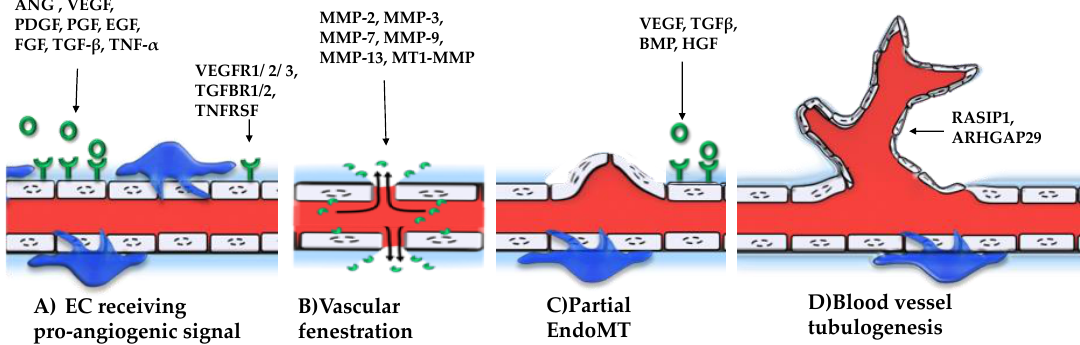
Figure 1. The angiogenic process has four main steps. ( A ) The endothelial cells (EC) found at the outer surface of a blood vessel, receive pro-angiogenic signals from the following factors: Angiogenin (ANG), Vascular Endothelial Growth Factor (VEGF), Platelet Derived Growth Factor (PDGF), Placental Growth Factor (PGF), Epidermal Growth Factor (EGF), Growth Factor Form Fibroblast (FGF), Transforming Growth Factor Beta 1 (TGF B), and Tumor Necrosis Factor Alpha (TNF- α ). The angiogenic growth factors have several corresponding receptors on the surface of EC, for instance VEGFR1/2/3, TGFBR1/2, TNFRSF. After signal transduction in the EC, these cells start to produce metalloproteinases. ( B ) At the same time, the blood vessel pores have an increase size and because of this fenestration, the MMPs are able to escape from the blood vessel and degrade the basement membrane. ( C ) Then the ECs start to migrate, through a process called partial endothelial to mesenchymal transition (partial EndoMT) and proliferate at the place of fenestration, resulting in the budding of a new blood vessel. ( D ) As the new tube forms, there are multiple signals, such as RASIP1 and ARHGAP29, received from the environment that will give the 3D structure and organization of the newly formed network. By the end of this stage, the pericytes found at the exterior of the blood vessel responsible for blood vessel contraction are also beginning to populate the newly formed network.